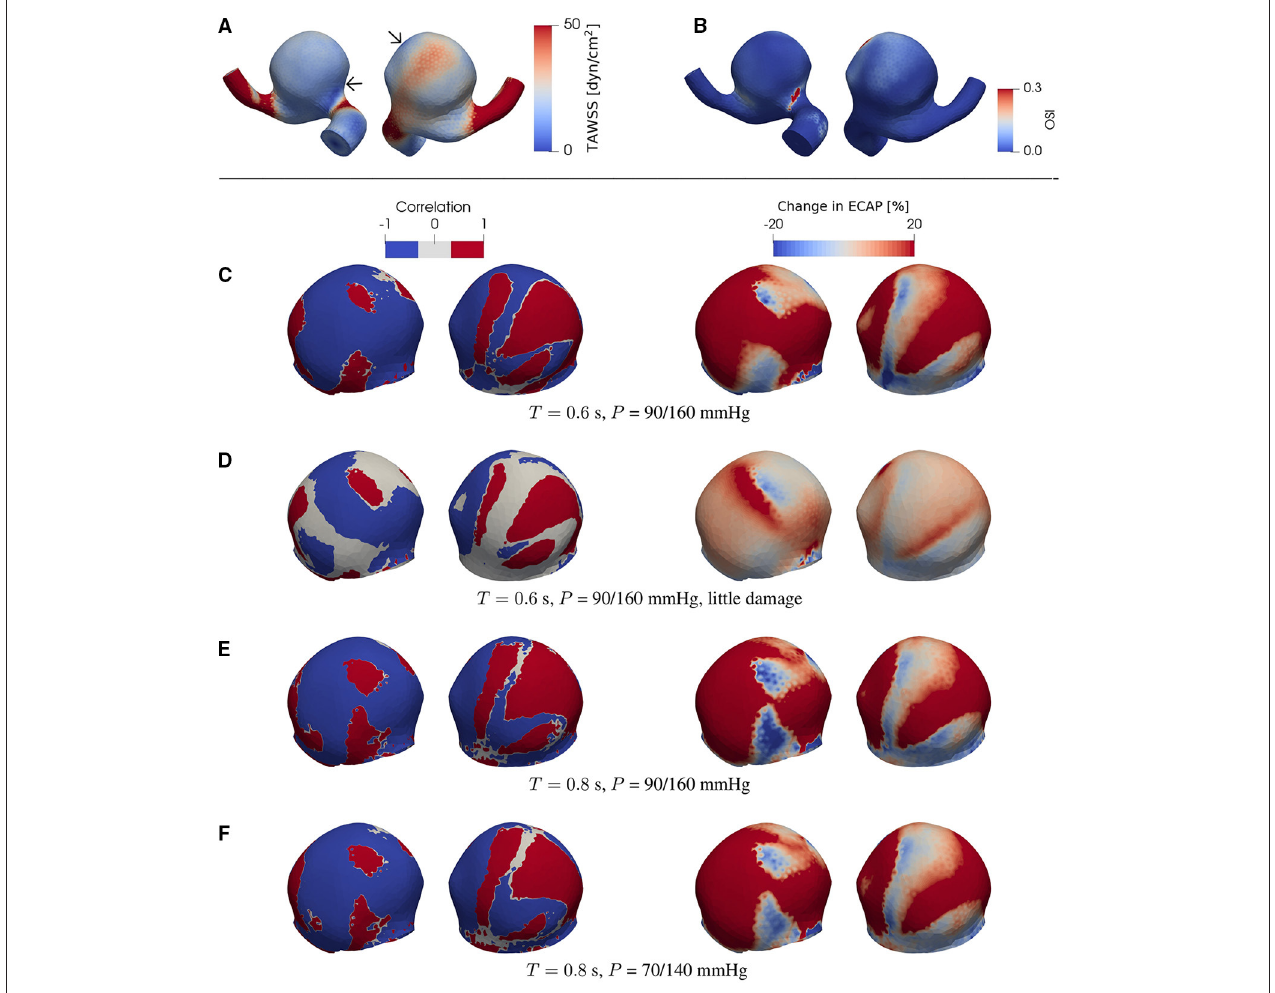
FIGURE 4 | (A) TAWSS and (B) OSI field in the presence of degradation using a patient-specific aneurysm geometry [C0034 in Aneurisk dataset repository (Aneurisk-Team, 2012); Figure 1C ]. (C–F) Product of degradation-induced relative changes in TAWSS and OSI (two left-hand columns; Equation 5) and the relative change in ECAP (two right-hand columns; Equation 4) under different damage intensities and flow conditions. The damage intensity in (C) is larger than that in (D) . (C,E) differ in only the heart rate (or duration of cardiac cycle T ). Compared to (E) , the pressure P in (F) is lower. In (C–F) , all negative and positive products (threshold = ∓ 5 % ) of the relative changes in TAWSS and OSI are set to –1 and 1, respectively. As indicated by comparisons between (A) and (C–F) , the degradation-enhanced inverse correlation between TAWSS and OSI remains intact particularly at regions with low WSS. For each case investigated, the locations of low-WSS (indicated by arrows) remain intact during a full cardiac cycle. The second (fourth) column shows the same simulated data as in the first (third) column but after rotating the aneurysm dome by an angle of π around the polar axis. In (C–F) we show only the aneurysm region since the degradation model is applied only on the aneurysm